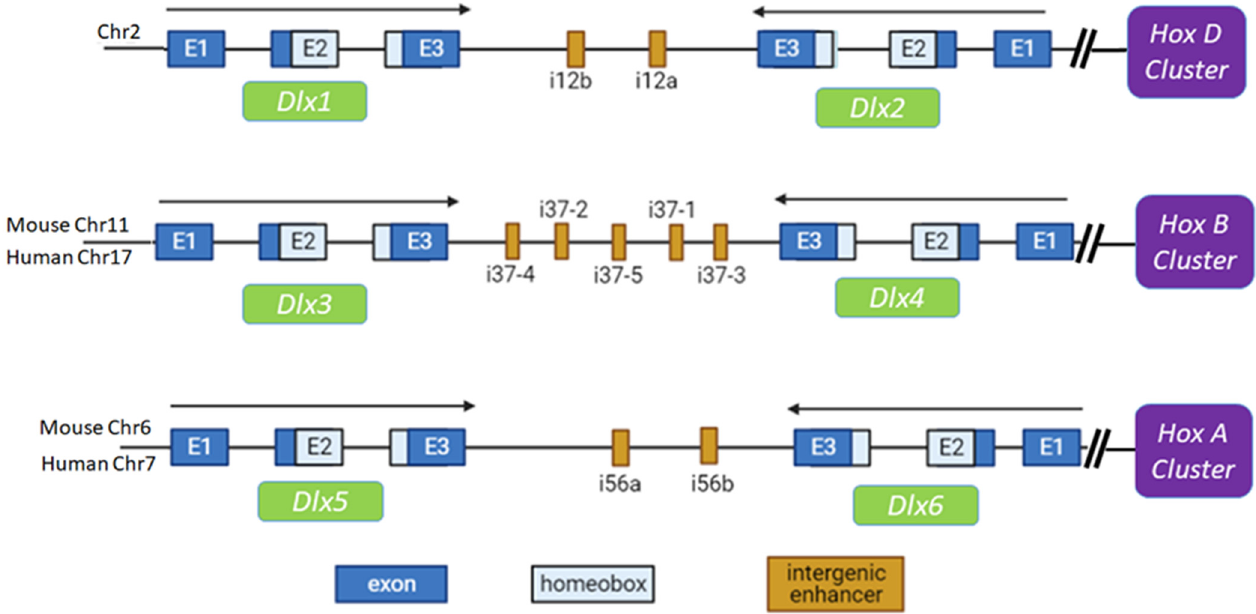
Figure 1. Structure of mouse and human Dlx gene family. The Dlx genes are comprised of three exons. The homeobox motif (light blue) resides within part of Exon2 and Exon3. The Dlx1/2 bigene is linked to the HoxD cluster on chromosome 2 in both human and mouse, with intergenic enhancer elements i12a and i12b. The Dlx3/4 bigene is linked to the HoxB cluster on mouse chromosome 11, with five intergenic cis elements. The Dlx5/6 bigene resides along with the HoxA cluster on chromosome 6, with i56a/b (or i56i/ii) as the intergenic